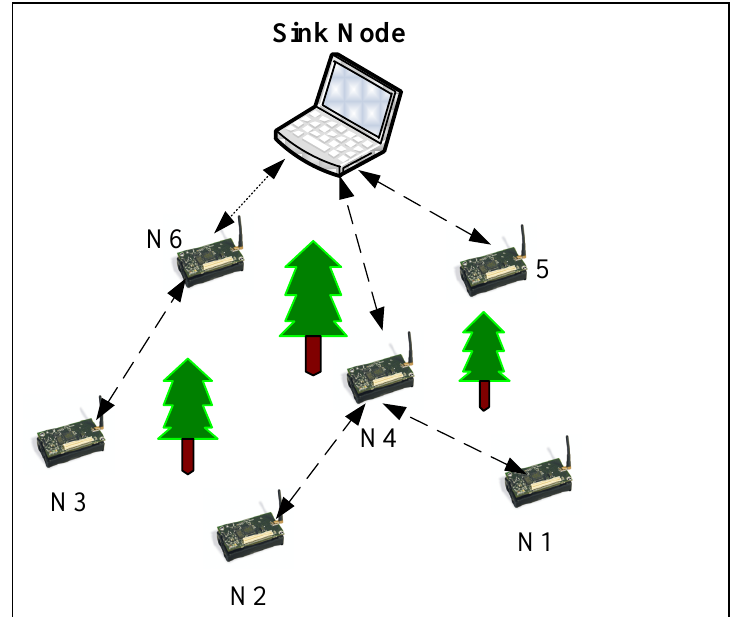
Figure 2. Architecture of a general wireless sensor